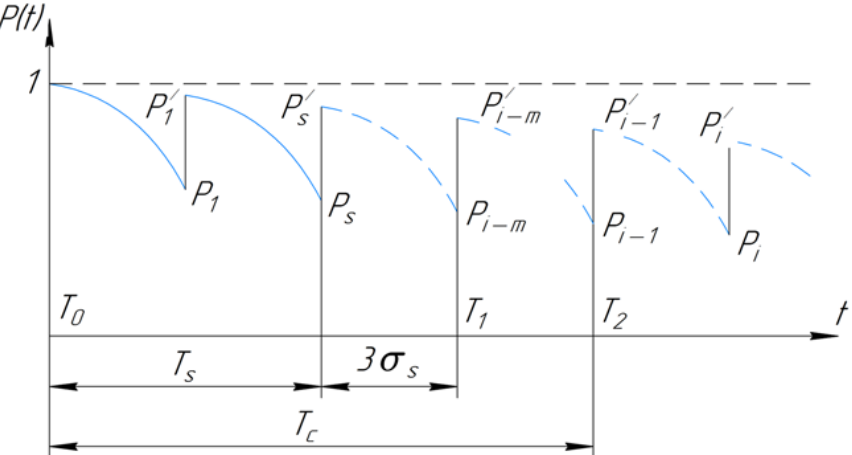
Figure 1. The model of changes in the technical state of units depending on the operating time: T s is the service life of elements; σ s is the mean-square deviation; Δ = T 2 - T 1 , which is the considered period within the evaluation of the repairs number; T c is the calculated time (in years).